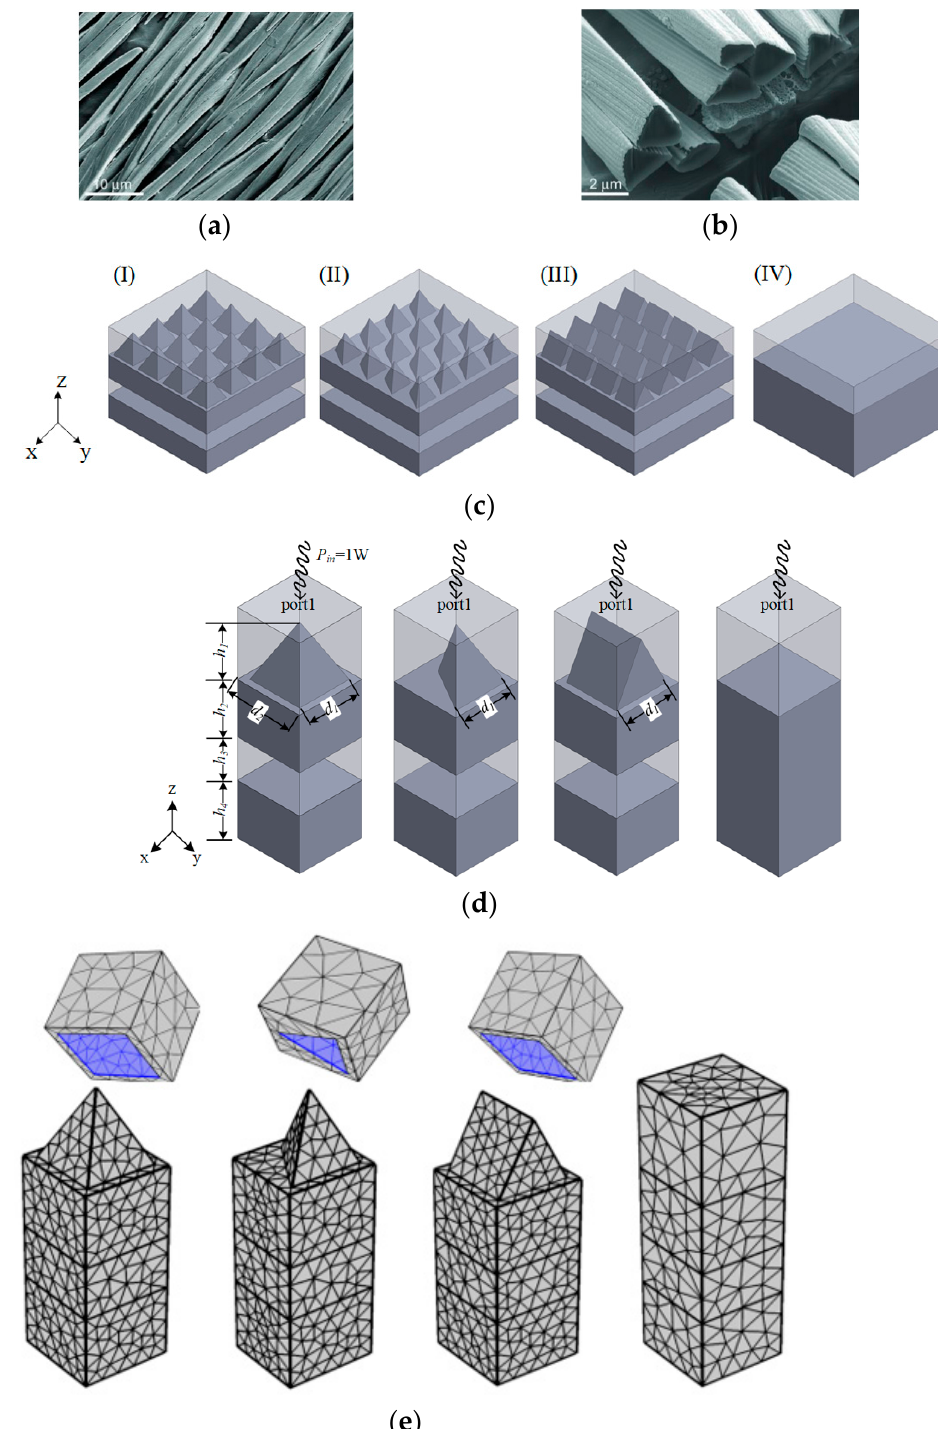
Figure 1. Hairs of Saharan silver ants and their biomimetic counterparts at the micro-nano scale. ( a ) Axial and ( b ) central cross-sectional images of SEM to illustrate the hairs of the real Saharan silver ants [11]. ( c ) Arrayed biomimetic micro-nano structures with individual units (e.g., pyramid (I), tetrahedron (II), triangular prism (III) and flat surface (IV) for comparison) before ( d ) and after ( e ) meshing with finite elements.